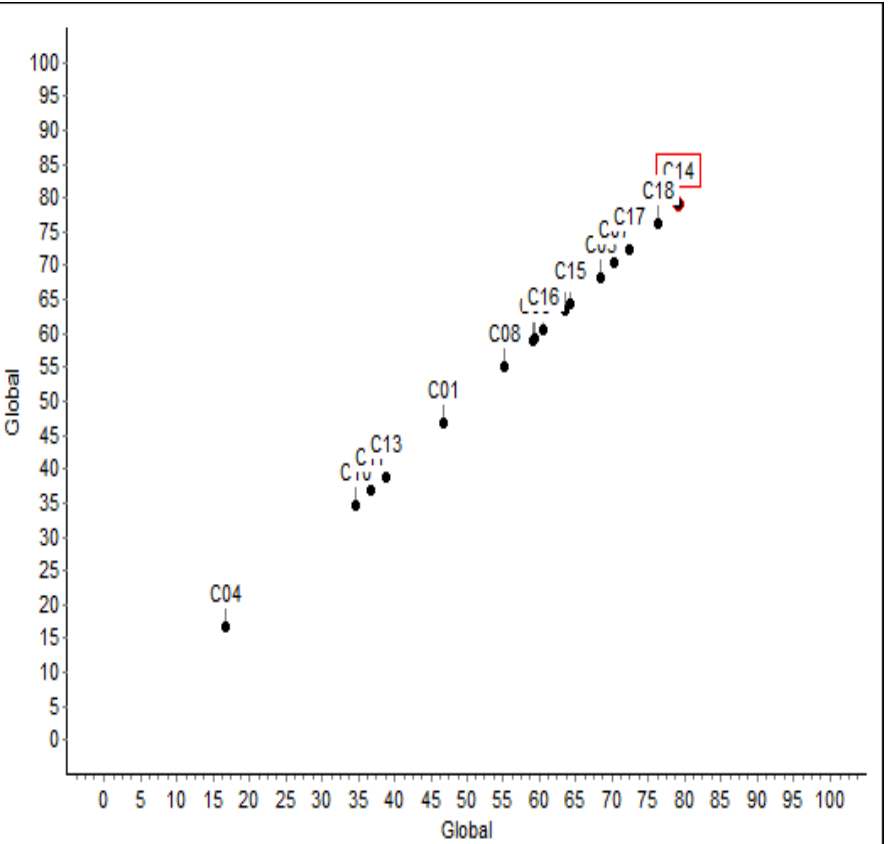
Figure 10. Evaluation of monitoring order on the boiler system.